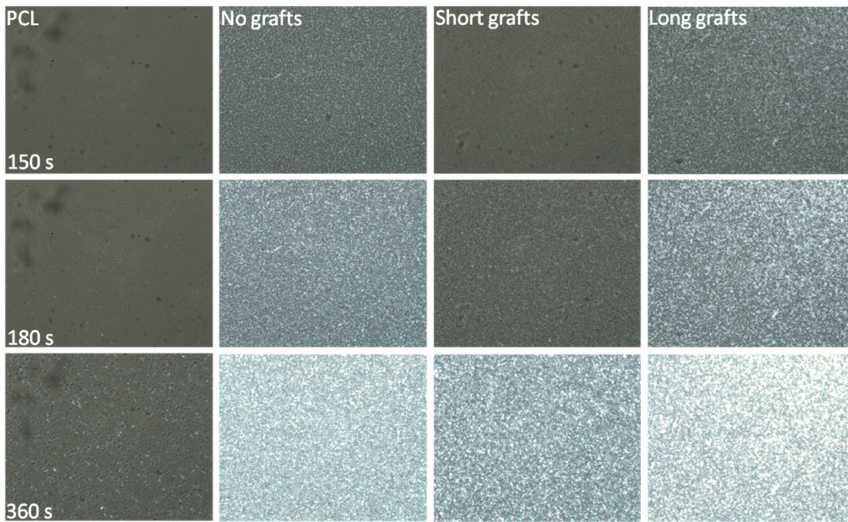
Figure 10. POM images taken during isothermal crystallisation at 44 ◦ C for di ff erent PCL / silica composites based on the PCL80 matrix and 1 wt%